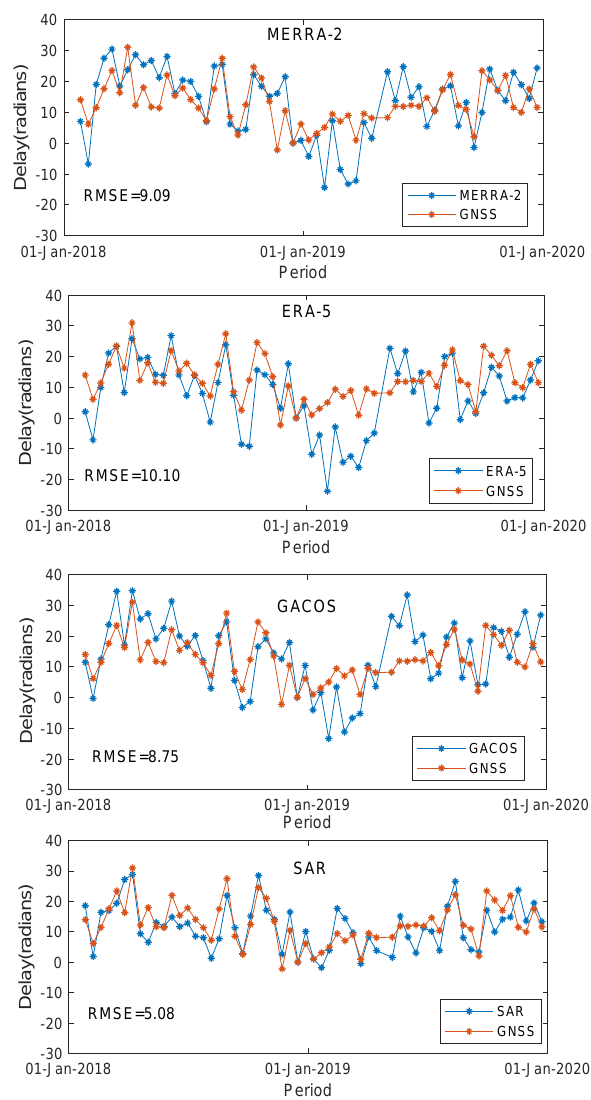
Figure 5. Time-series comparison of NWM tropospheric delays and SAR tropospheric delays with GNSS tropospheric delays at GNSS station KYN5. The tropospheric delays are referenced to GNSS station KYN7 and date 12-16-2018.